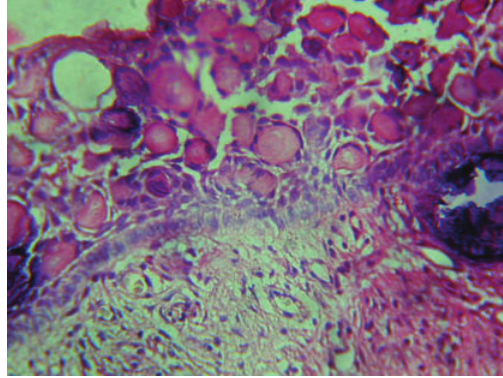
Figure 7: Cystic lumen lined by odontogenic epithelium and areas of “Ghost” epithelial cells projecting into the lumen with areas showing calcification (H and E Stained ×